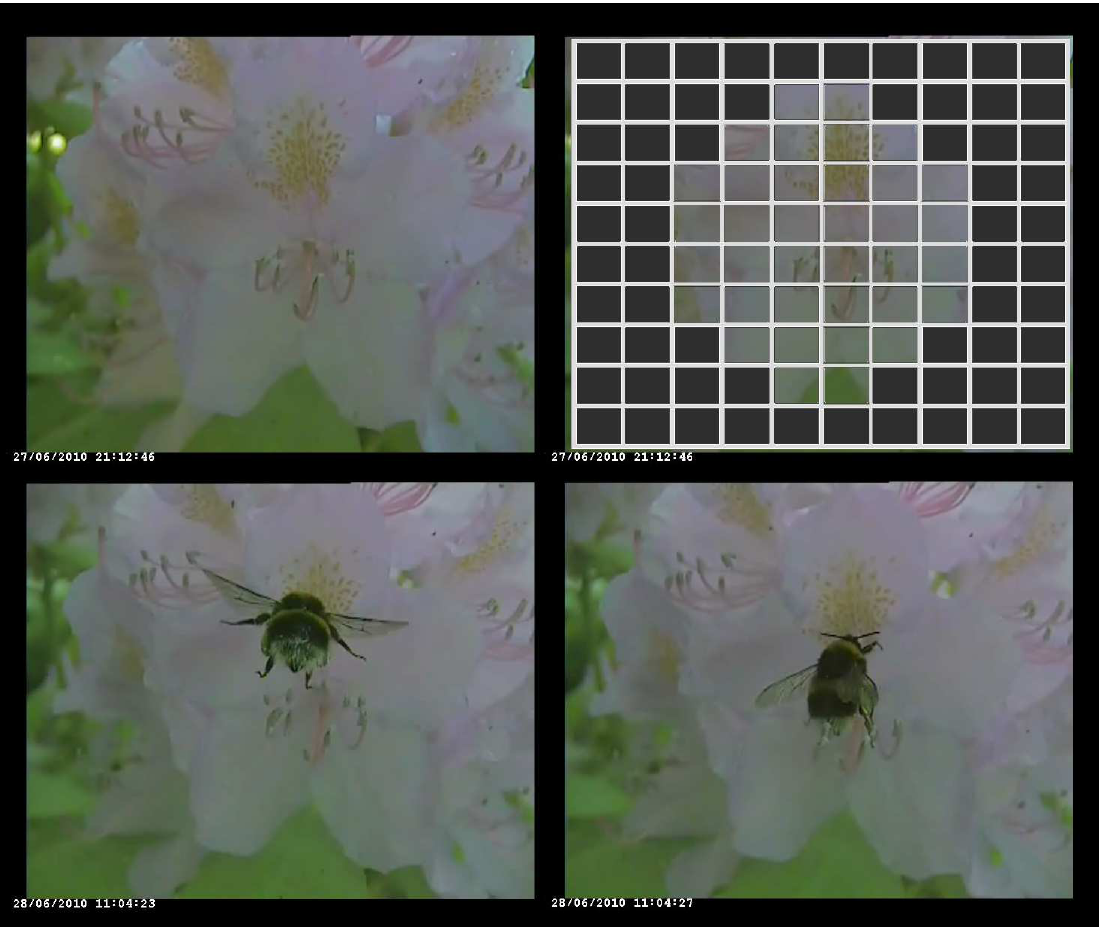
F IG . 2. Screenshots from recordings made of the rhododendron illustrating the video motion detection sensor. The upper left picture shows the camera view of the capitulum. The upper right picture shows the area that was masked (i.e. the dark grey square boxes). Only the unmasked area is sensitive to movements and triggers the recordings. In the lower left picture the approaching bumblebee that triggers the recording. In this case (picture lower right) it was a classified to B. terrestris / B. lucorum